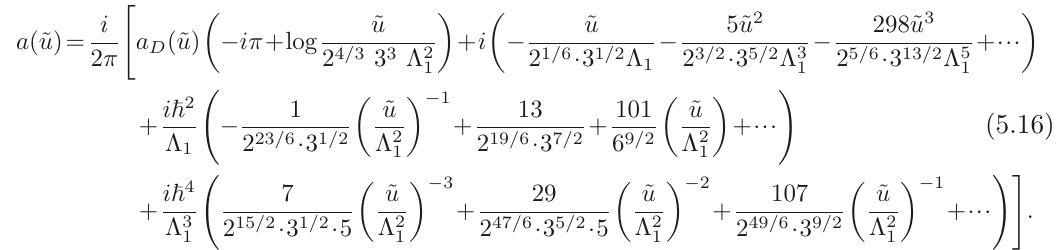
Table 2 . The coefficients of the dual prepotetials for the N f = 1 theory, where ˜ c (1) = 2 − 17 / 6